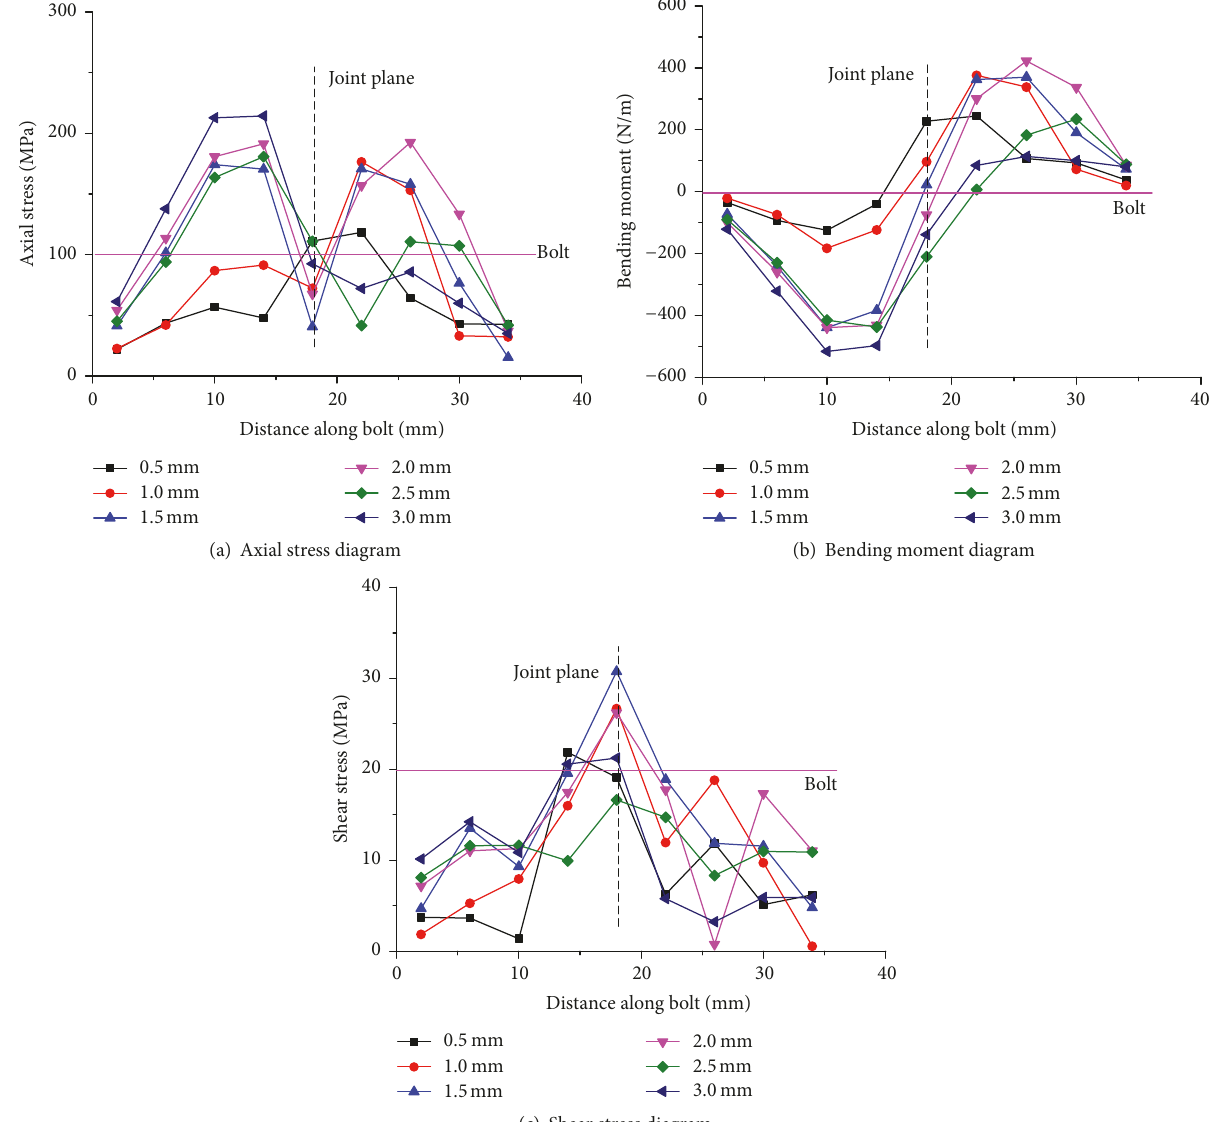
Figure 10: Bolt stress state diagram at an anchorage angle of 75 ∘